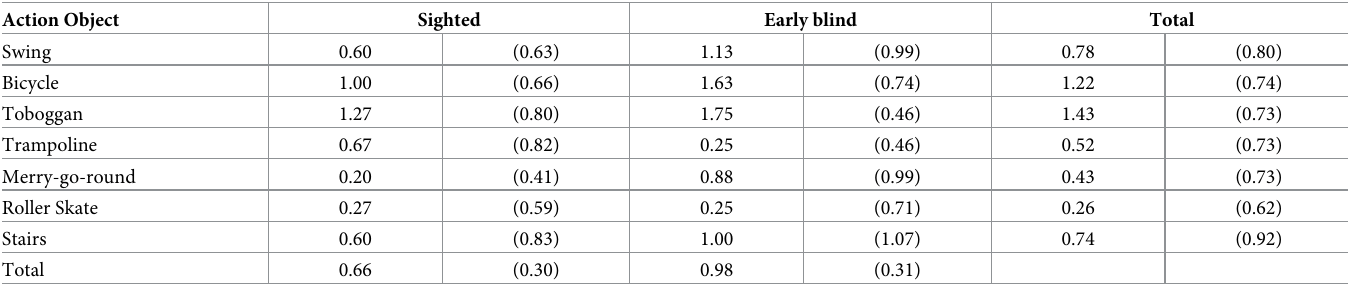
Table 4. Identification scores (max 2.00) and (SD) in sighted (N = 15) and early blind children (N = 8) for each action object represented with a textured picture. Action